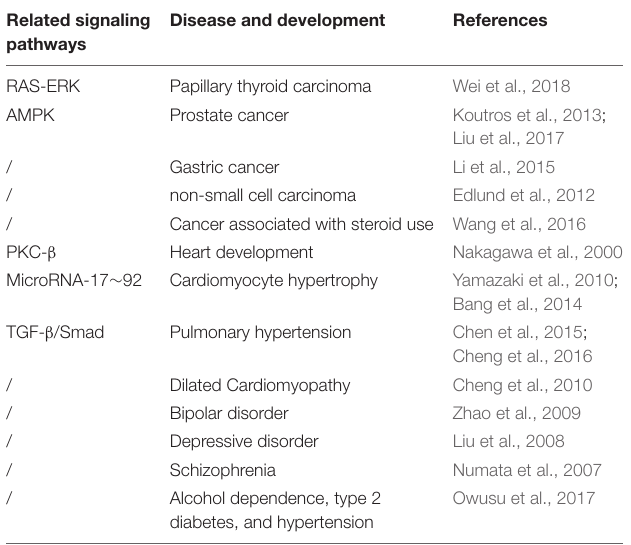
TABLE 2 | List of different disease involved in